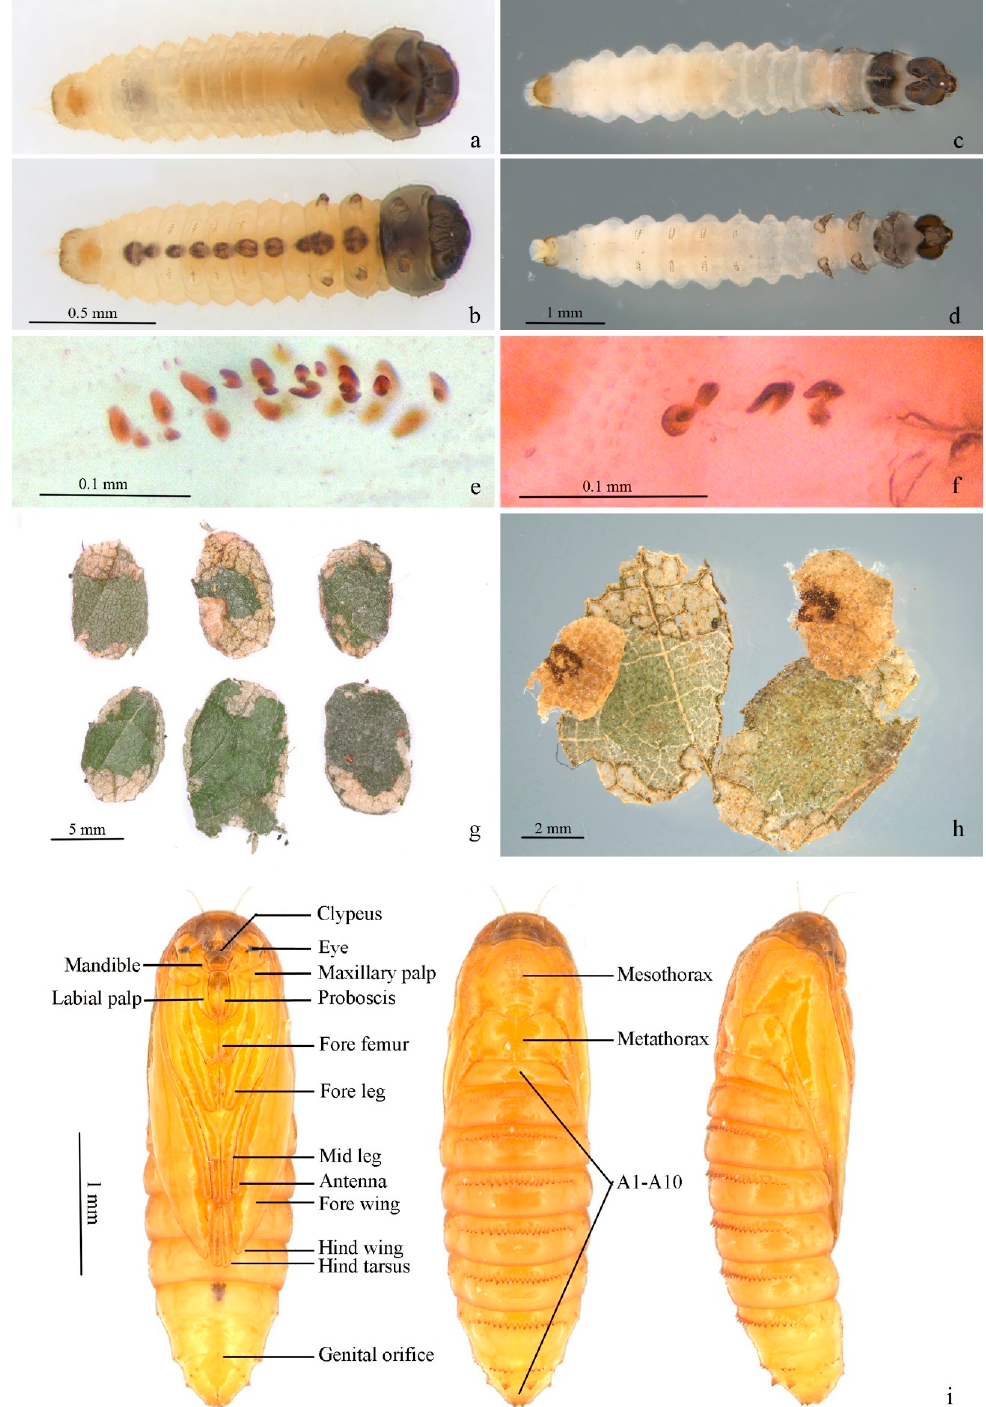
Figure 6. Immature stages of Subclemensia taigae . ( a , b ) First instar in case: ( a ) dorsal view, ( b ) ventral view; ( c , d ) mature larva, boiled in water: ( c ) dorsal view, ( d ) ventral view; ( e ) crochets on A3–6; ( f ) anal crochets; ( g ) portable case for overwintering; ( h ) opened case, showing the two layers and the feces attached on the outer surface of the inner layer; ( i ) pupa from ventral, dorsal and lateral views.